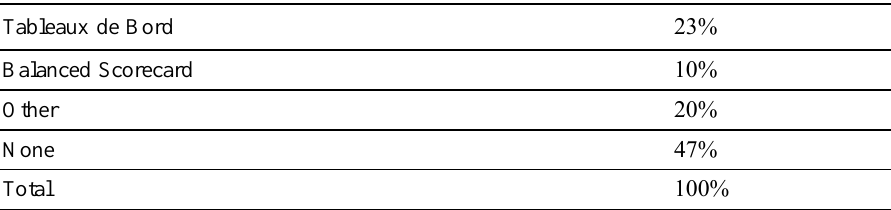
Table 8. Management control system in use